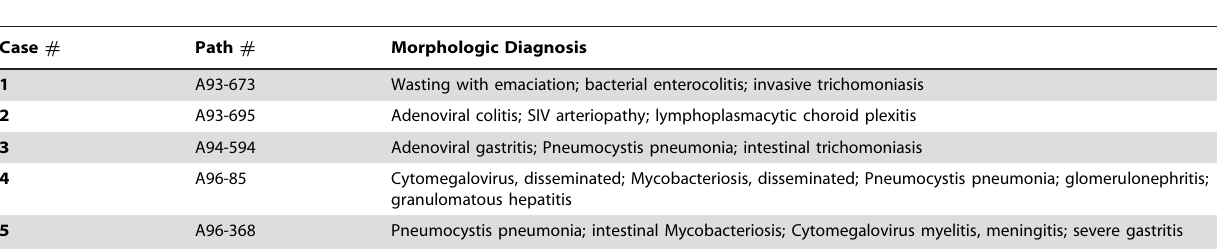
Table 2. SIV D vpx systemic and neuropathologic findings associated with terminal AIDS.